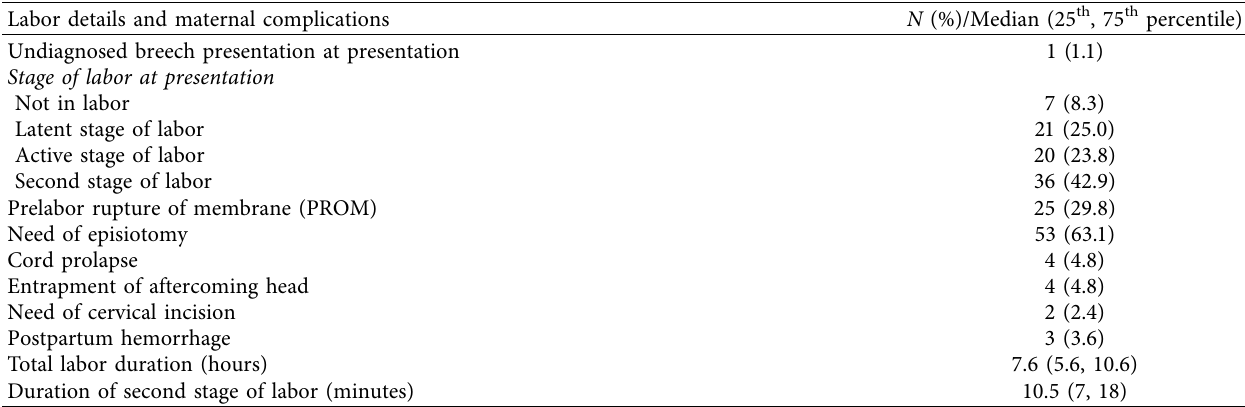
Table 2: Details of labor and maternal